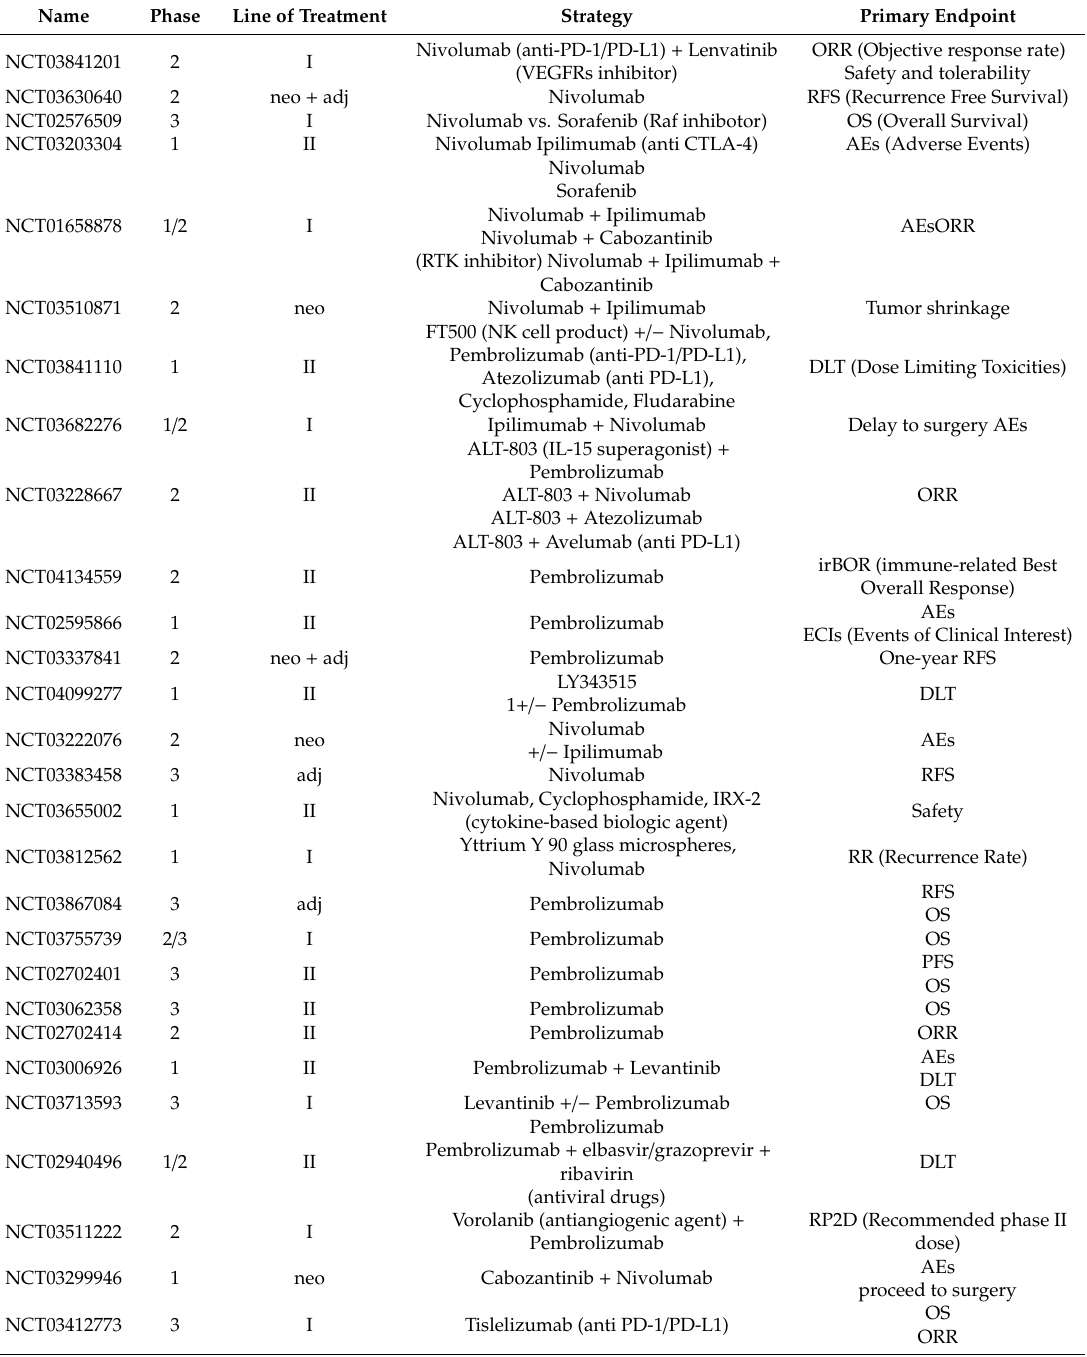
Table 2. Major trials in HCC involving anti-PD-1 / PD-L1 agents-based